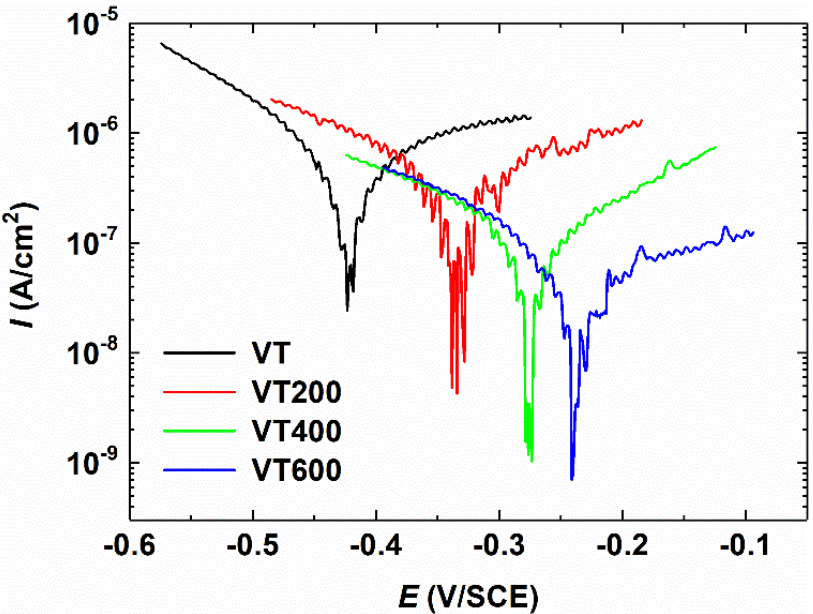
Figure 5. Polarization plots of tantalum coatings thermal treated at different temperatures.